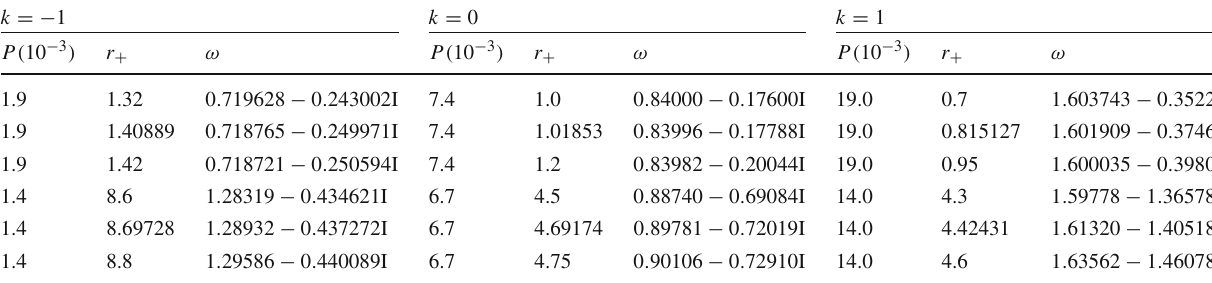
Table 3 The QNM frequencies change as the black hole horizons r